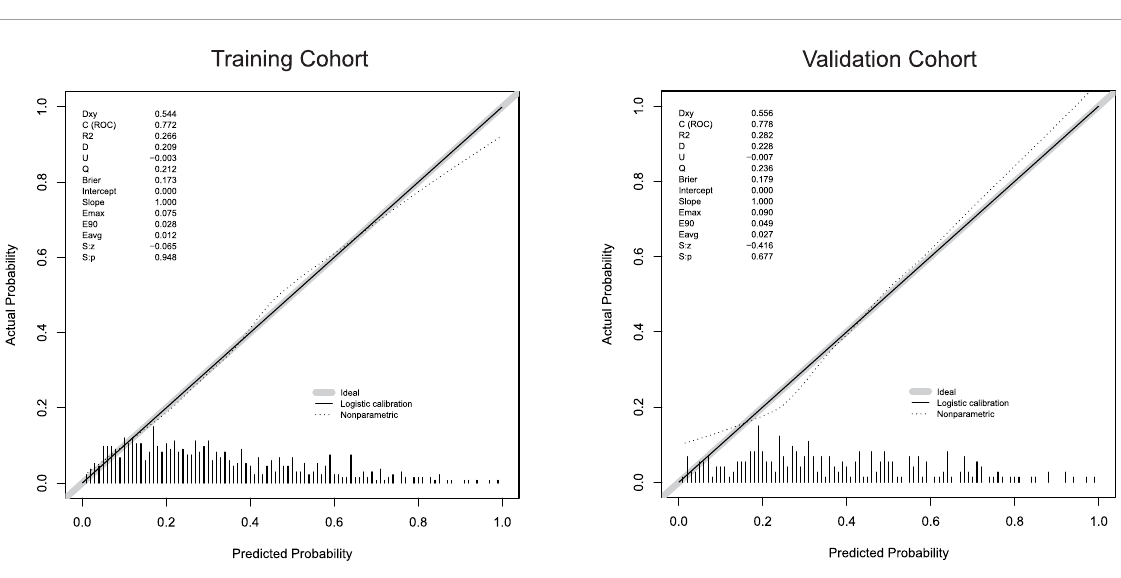
FIGURE5 Calibration curves for the training cohort and the validation